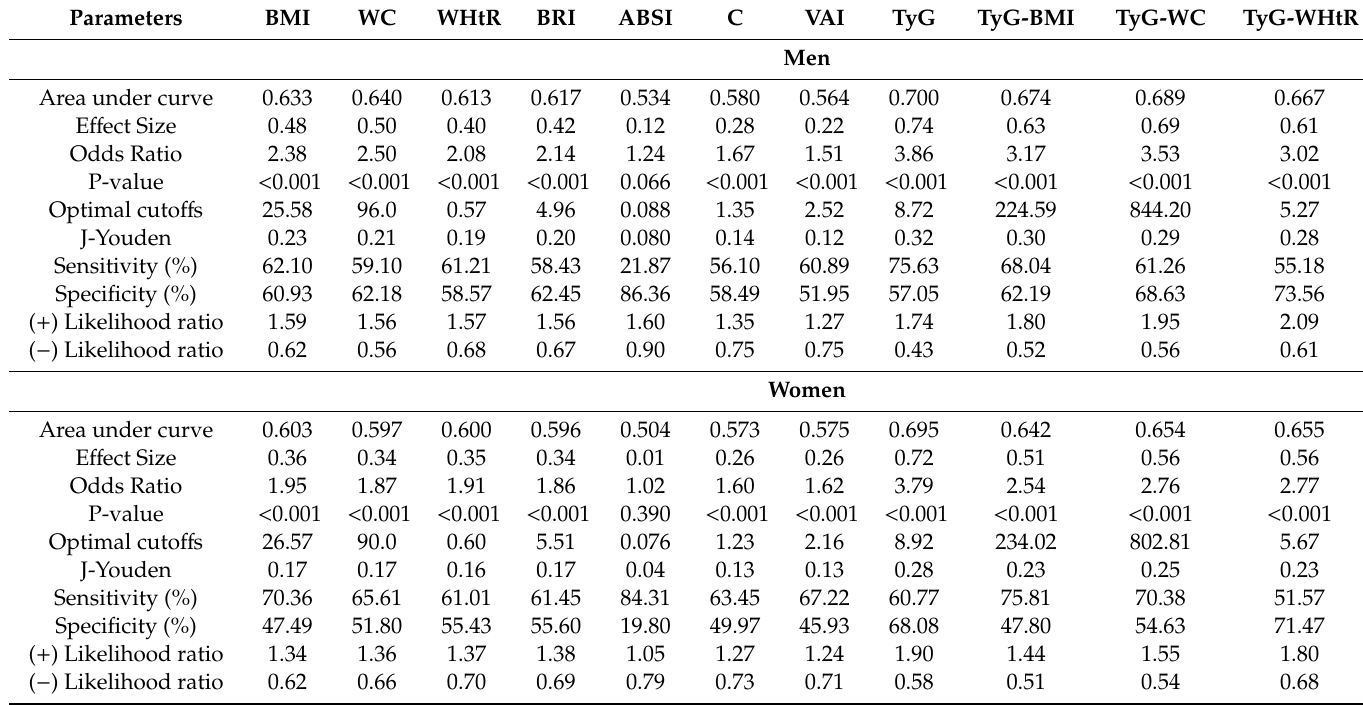
Table 2. Cut-o ff between area under curve, sensitivity and specificity for obesity- and lipid-related indices to detect high prediabetes risk by sex.